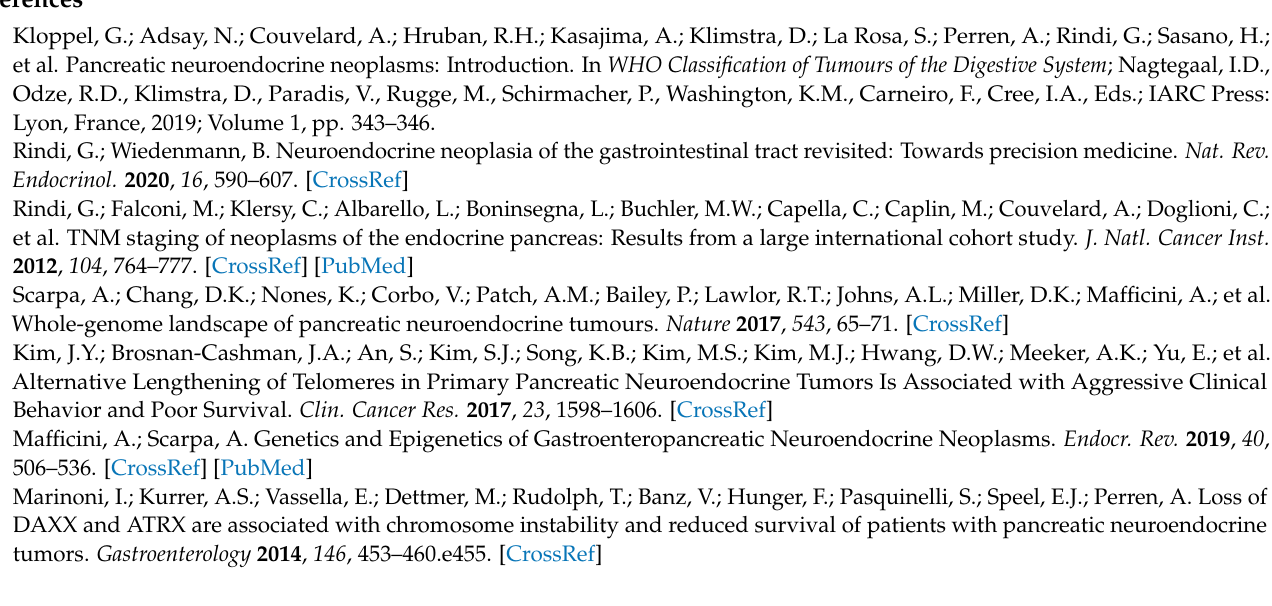
Table S2. List of 3050 differentially expressed genes between PanNETs of different grades identified by Deseq2 analysis. Table S3. KEGG pathway enrichment analysis of 1104 genes differentially expressed in G3 vs. G2-G1 PanNETs. Table S4. Detail of sequencing coverage of 29 PanNET samples (all primaries except for sample of patient #6—G3 metachronous recurrency). Table S5. Mutations identified in 29 samples of PanNET using an Ampliseq custom panel for 16 genes (all primaries except for sample of patient #6—G3 metachronous recurrency). Figure S1. Disease-specific survival according to gene expression cluster in 25